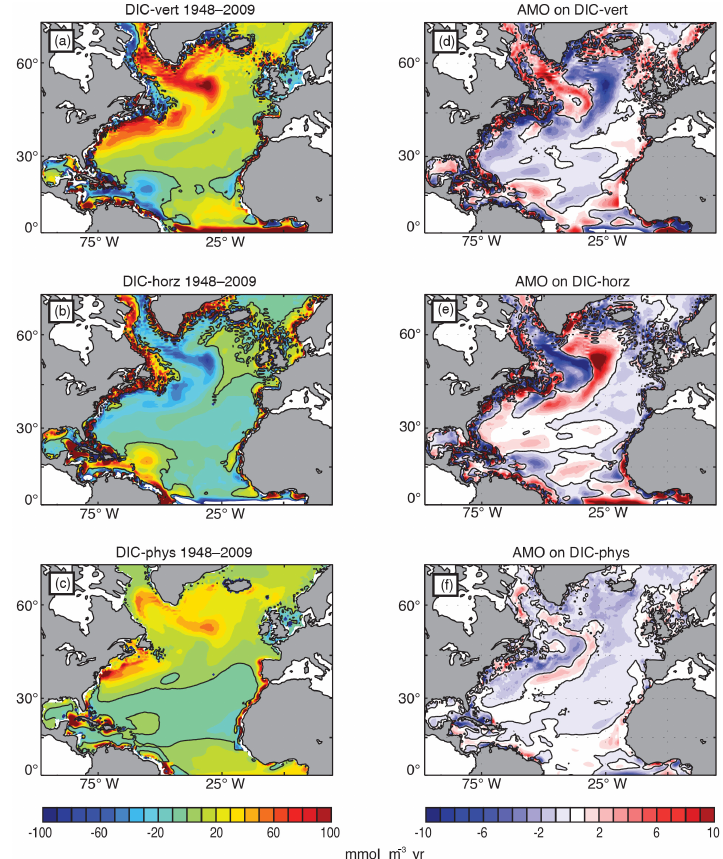
Figure 4. DIC diagnostics. Left column: 1948–2009 mean (a) DIC-vertical; (b) DIC-horizontal; and (c) DIC-physical, where DIC-physical is the sum of DIC-vertical and DIC-horizontal. Right column: AMO regressed onto (d) DIC-vertical, (e) DIC-horizontal, and (f) DIC-physical. Units: mmolm − 3 yr − 1